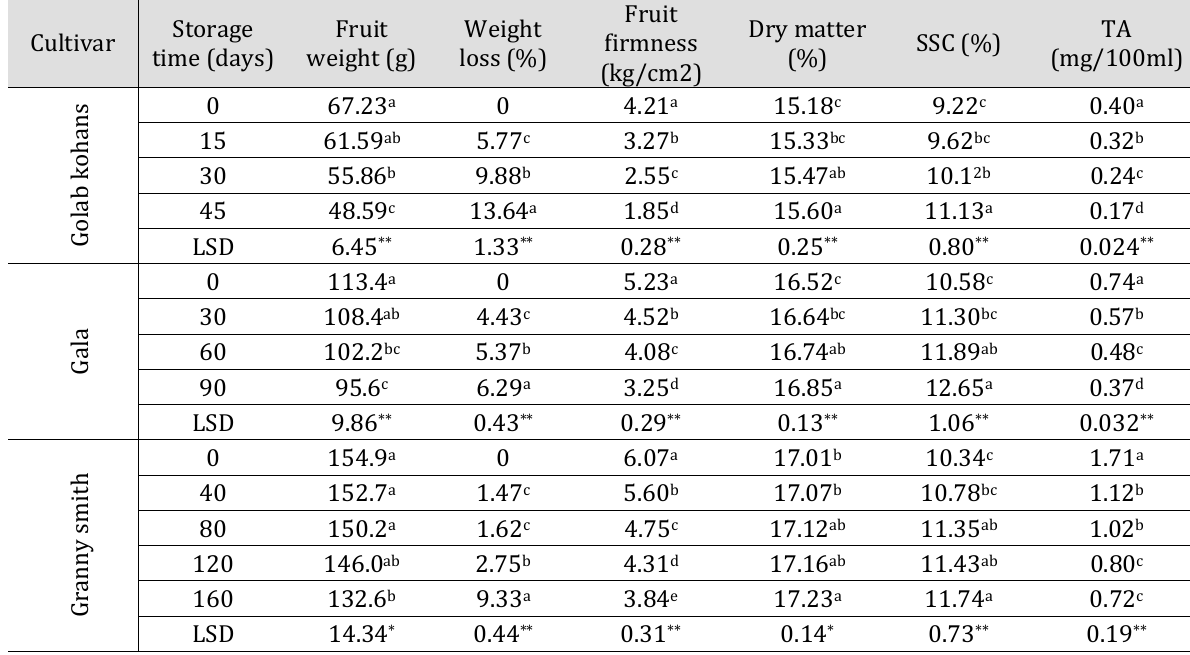
Table 2. Post-harvest traits changes during cold storage period at 0±1 ○ C and 90 - 95 % relative humidity for three apple cultivars (Golab Kohans, Gala and Granny